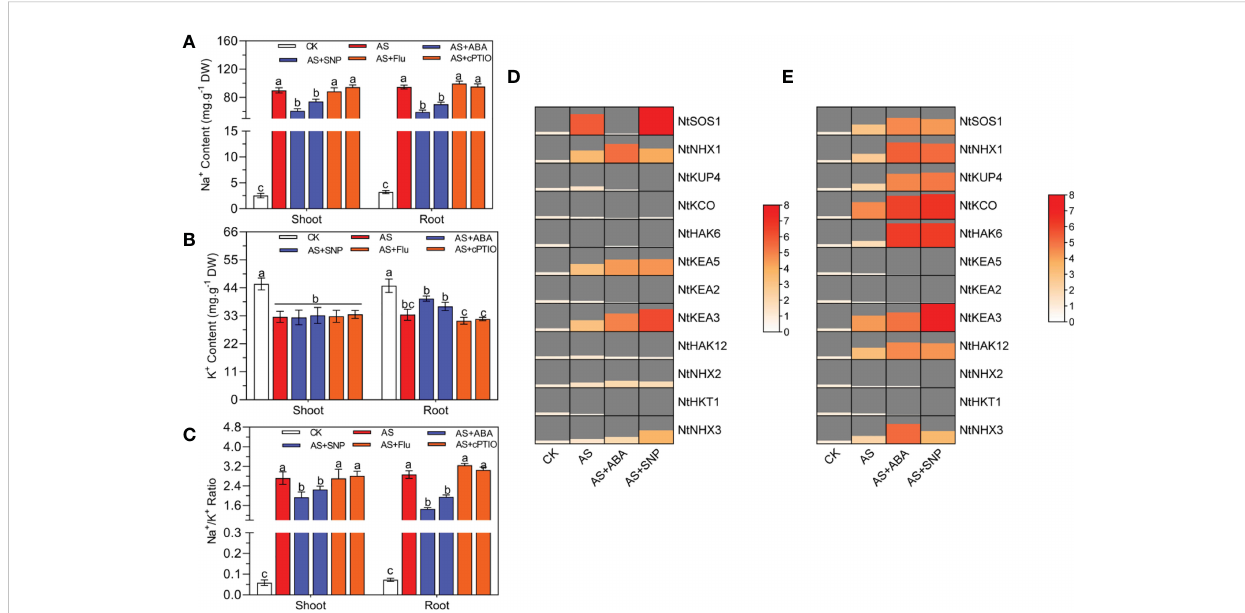
FIGURE 3 Ion content and quanti fi cation of related genes in N. tangutorum seedlings under different treament. 40-day-old seedlings were treated with different treatments (100 mM alkali, 100 mM alkali +15 m m ABA/5 m m Flu, 100 mM alkali +50 m m SNP/70 m m cPTIO) for 12 days(AS : NaHCO 3 : Na 2 CO 3 = 9:1, PH=9.5). Plants grew in Hoagland solution served as controls (CK). (A) Na + content, (B) K + content, (C) the Na + /K + ratios, (D, E) The expression level of ion transporter genes in leaf and root, including NtSOS1, NtNHX1/2/3, NtKUP4, NtKCO, NtHAK6/12, NtKEA2/3/5 and NtHKT1 . Bars represent the means ± SDs of three replicates. Signi fi cant differences among treatments are indicated by different letters within a panel based on Duncan ’ s multiple range test ( P <